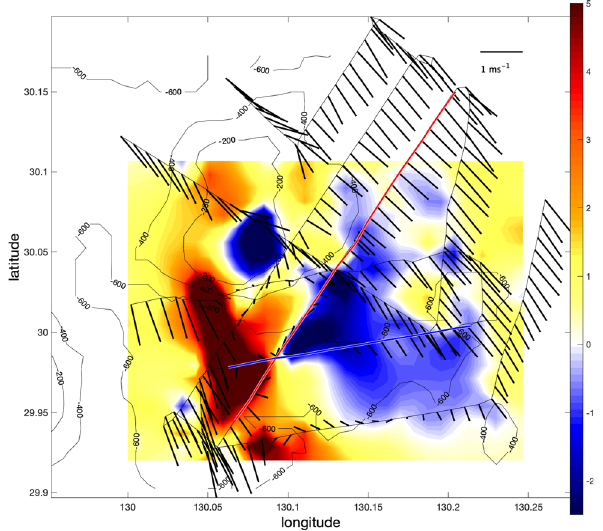
Fig. 4 Current velocity and absolute vorticity near Hirase submarine rise in the Tokara Strait during the June 2018 cruise. The average upper 200 m current is shown as vectors along the ship track, and color indicates absolute vorticity ( f + v x − u y ) f – 1 computed using the optimal interpolation of measured velocity with decorrelation length of 50 km, where f is the Coriolis parameter, v and u are meridional and zonal velocity, respectively, and subscripts x and y are derivatives along the zonal and meridional directions, respectively. Contours represent the topography